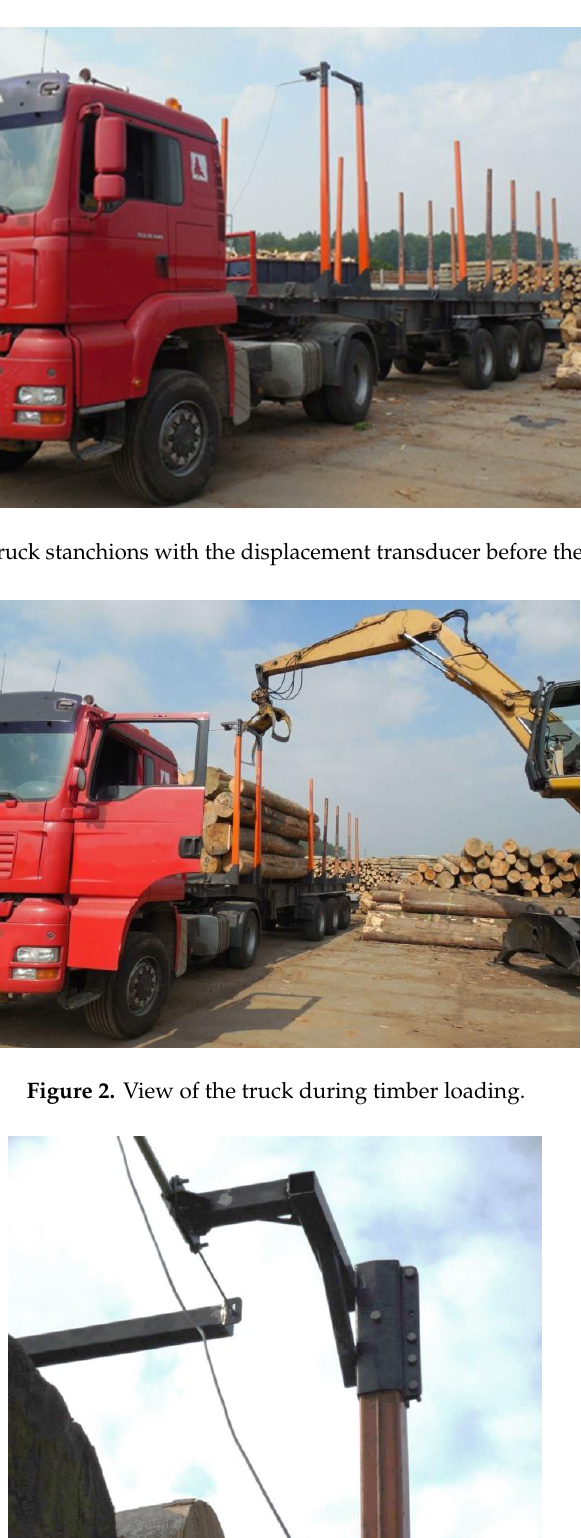
Figure 3. Displacement transducer mounted on the unloaded stanchion.